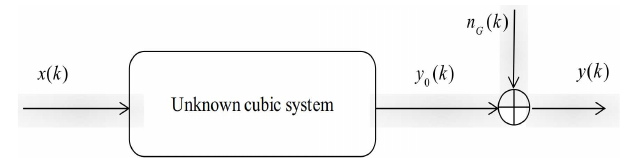
Figure 1. Nonlinear cubic